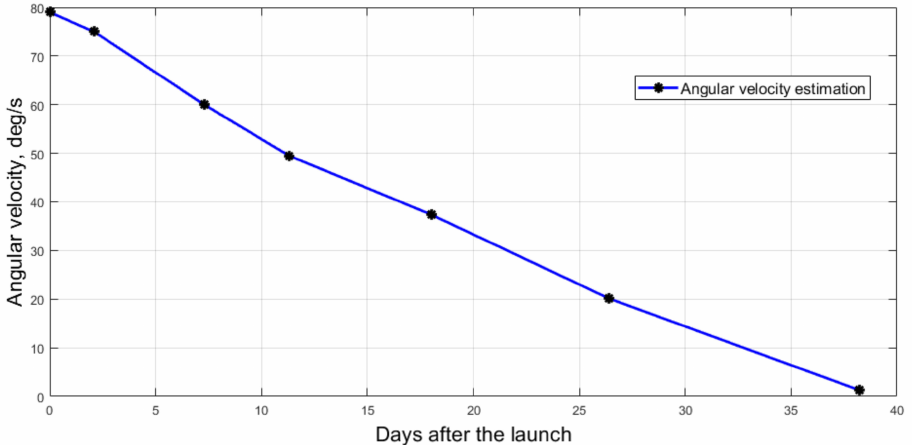
Figure 8. Angular velocity damping history.